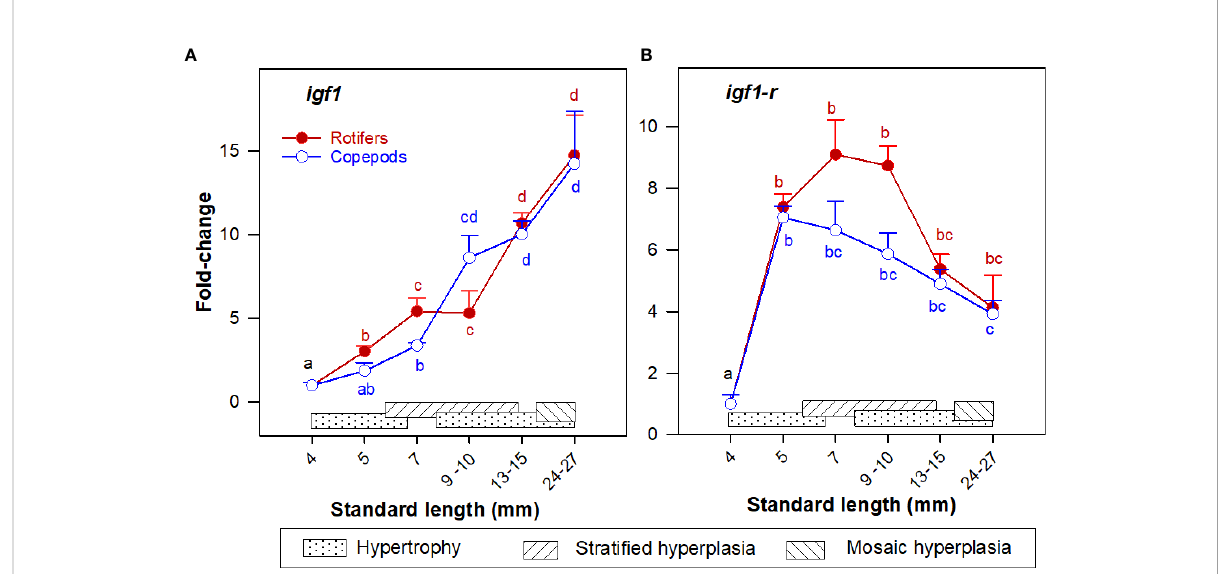
FIGURE 3 Gene expression (RNA-seq) of (A) igf1 ; and (B) igf1r in whole-body Atlantic cod larvae fed rotifers/ Artemia (red line) or copepods (blue line) in relation to muscle growth dynamics. Muscle growth dynamics (hypertrophy and strati fi ed and mosaic hyperplasia) in relation to body size are indicated by horizontal bars (data from Vo et al., 2016). Data are given as mean (n=3 [n= 4 at 4 dph] ± SEM) and values are expressed as fold change compared to day 4 post-hatch. Different letters indicate signi fi cant differences between the larval stages and treatments (P <